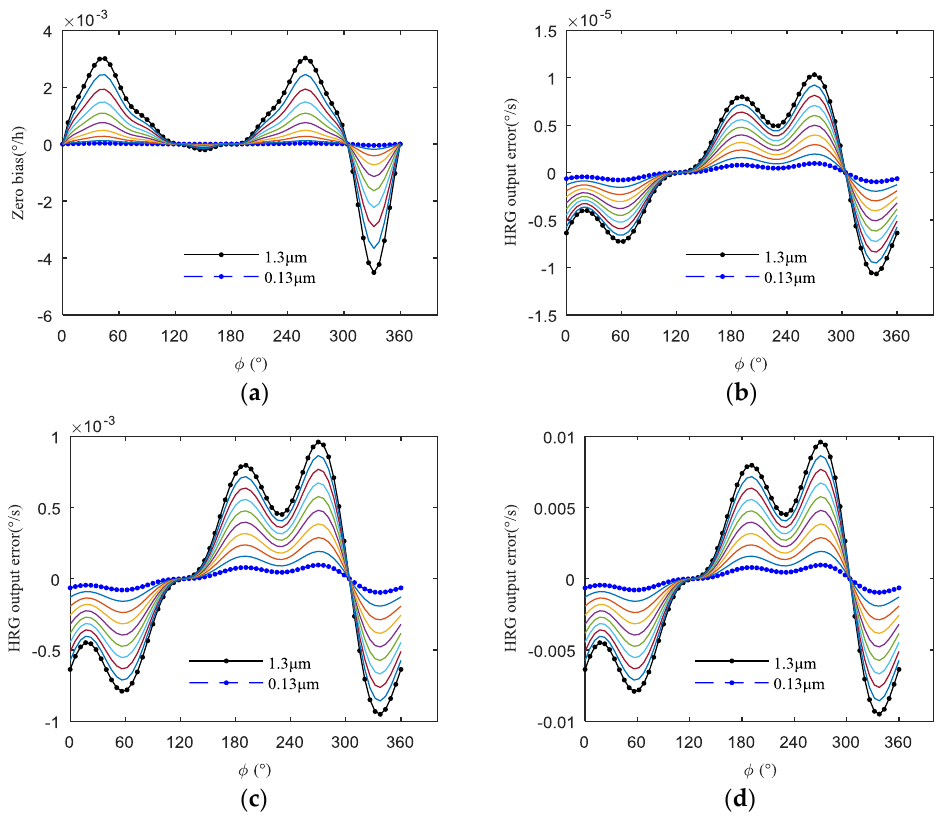
Figure 8. The HRG output error caused by the first four harmonics of uneven capacitance gap under the different input angular rates are respectively: ( a ) Zero bias caused by the first four harmonics; ( b ) Output error (Input: 10 −3 °/s); ( c ) Output error (Input: 0.1°/s); ( d ) Output error (Input: 1°/s).